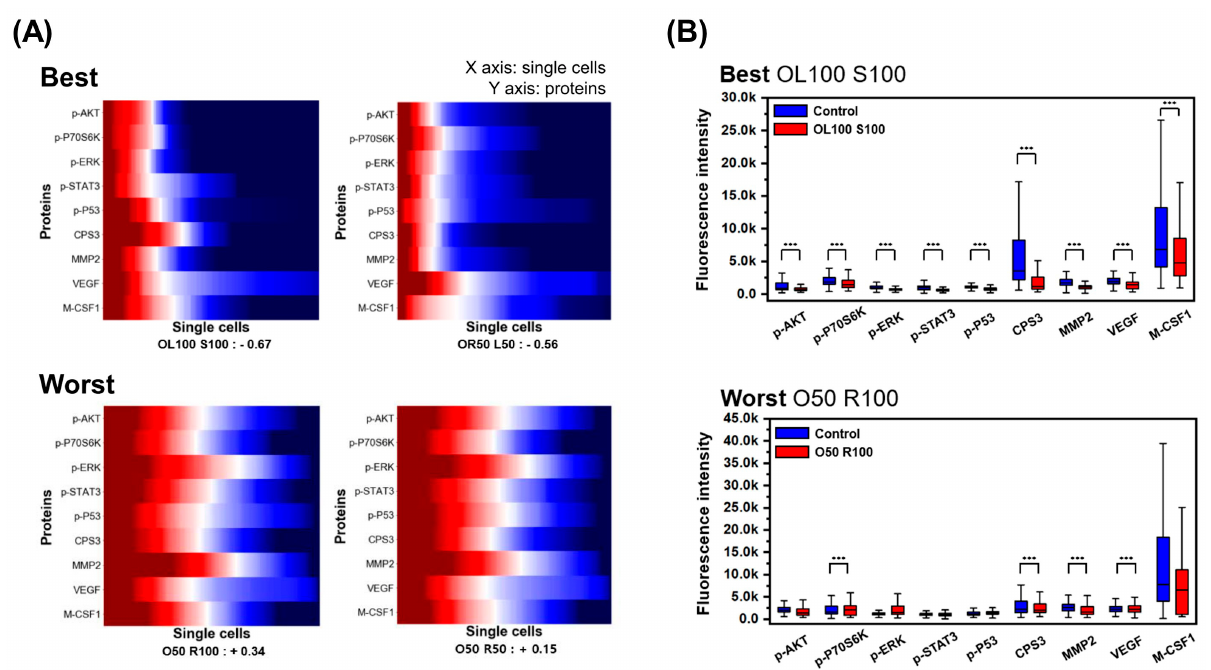
Figure 4. Single-cancer-cell proteomics analysis. ( A ) Heat maps showing protein concentration in best (OL100 S100, OR50 L50) and worst (O50 R100, O50 R50) drug treatment groups at the single-cell level are shown. ( B ) Box plots for protein concentration in best (OL100 S100) and worst (O50 R100) drug groups compared with control groups are shown. The number of asterisks corresponds to the following p -values. * p -value < 0.05, ** p -value < 0.01, *** p -value < 0.001. O, Oximertinib; L, LY294002; R, Ruxolitinib; S, Selumetinib.